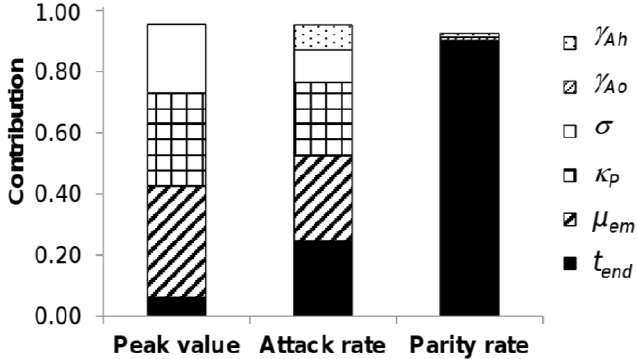
Figure 5. Contribution of model parameters to model output variance. Only parameters contributing to more than 1% of output variance were retained here. No interaction was retained.